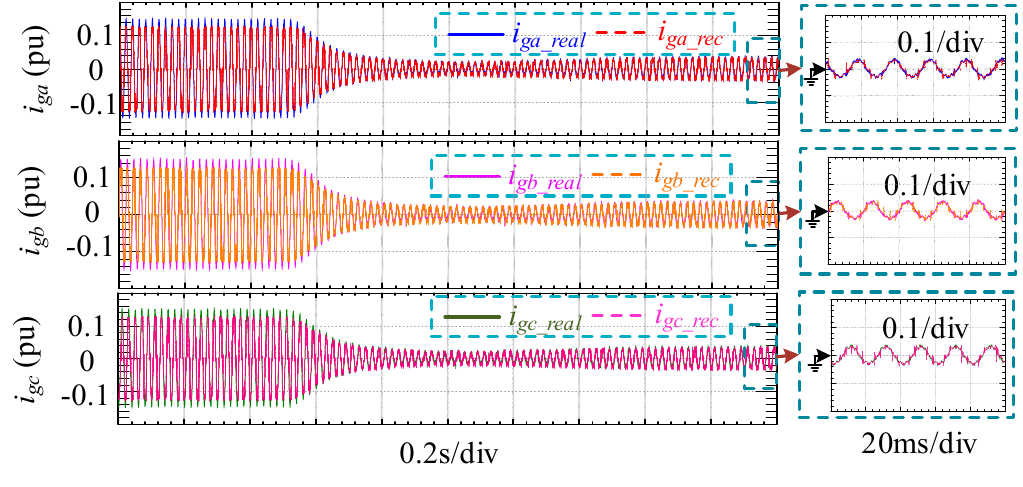
Figure 14. Three-phase output: ( a ) voltages; and ( b ) currents to the AC grid. Energies 2018 , 11 , 21 17 of 24